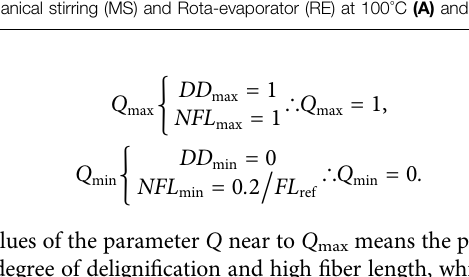
Frontiers in Chemistry |